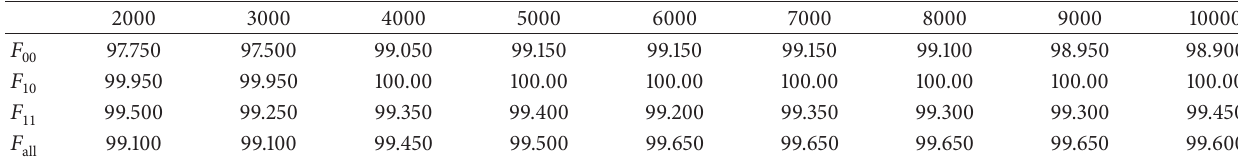
Table 1: Classification accuracy rates (%) (12000 samples).